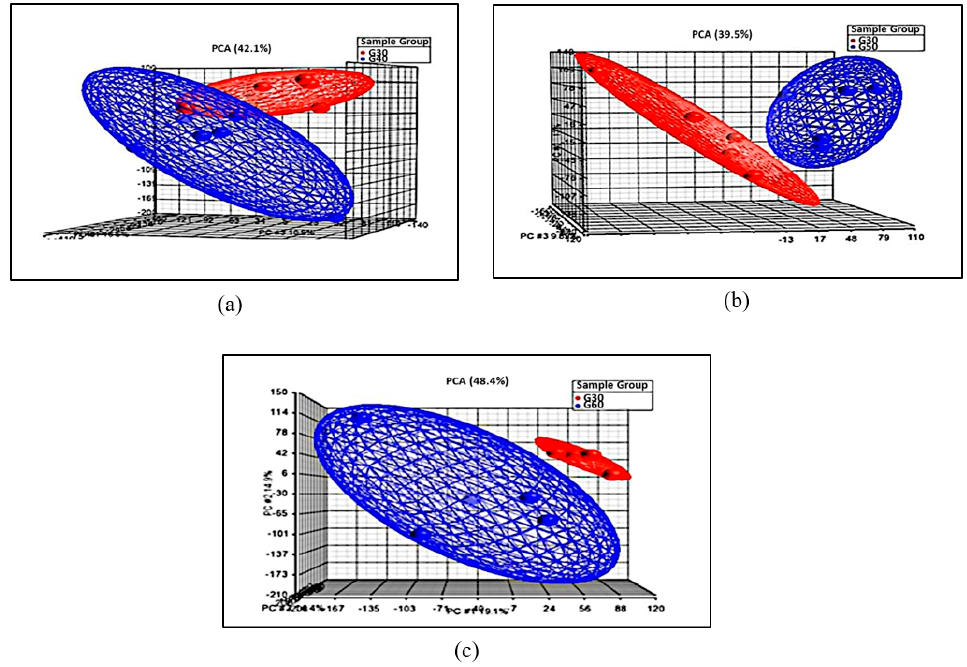
Figure 2. Principal component analysis (PCA). ( a ) Age group 40 (blue) compared to age group 30 (red), ( b ) age group 50 (blue) compared to age group 30 (red), ( c ) age group 60 (blue) compared to age group 30 (red).